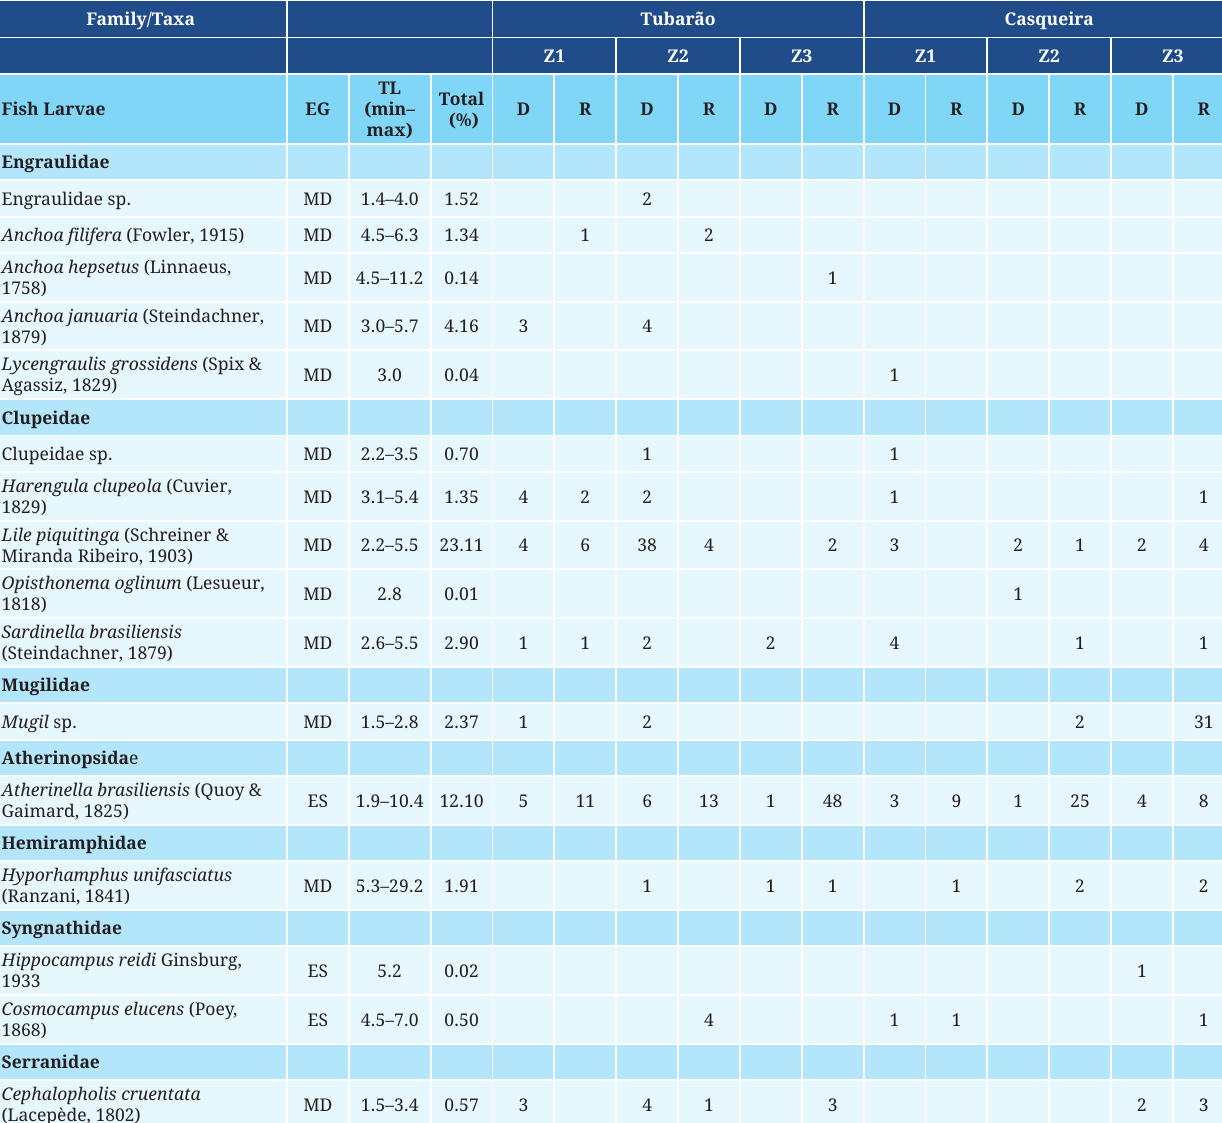
TABLE 3 | Number of fish larvae and fish eggs caught in both estuaries (Tubarão and Casqueira rivers) during dry (D) and rainy (R) periods. Zones (Z1 = Lower; Z2 = Middle; Z3 = Upper); EG = Ecological guild (MD = Marine estuarine dependent, ES = Estuarine solely); TL = Total length (min = minimum, max = maximum); Total (%) = % of all species